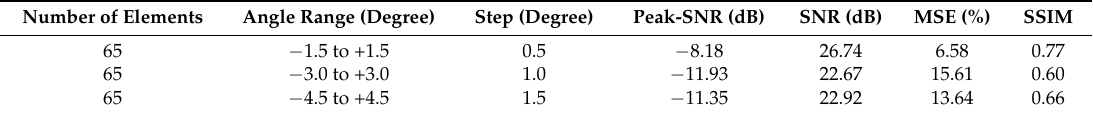
Table 7. Image quality values of Peak-SNR, SNR, MSE, and SSIM obtained with 65 active elements being excited in a different angle range and using as a reference the images obtained with all 128 active elements and the same angle